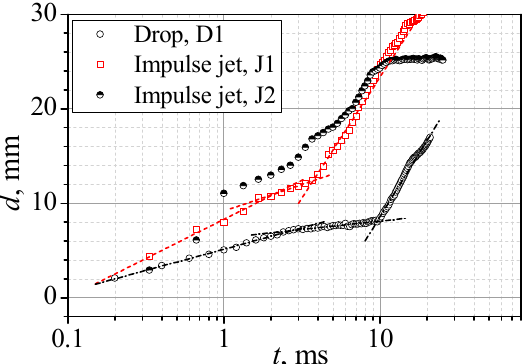
Figure 9. Time history of the cavity diameters for cases D1, J1, and J2. The dashed lines show the approximations (1) for each stage, see parameters in Table 4.